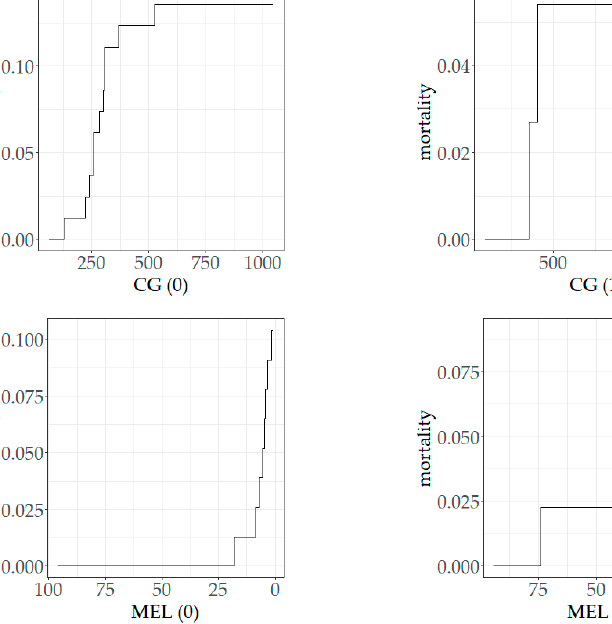
Figure 4. The statistical connection between the percentage of deaths in AIS patients and the value of the assessed biomarkers.